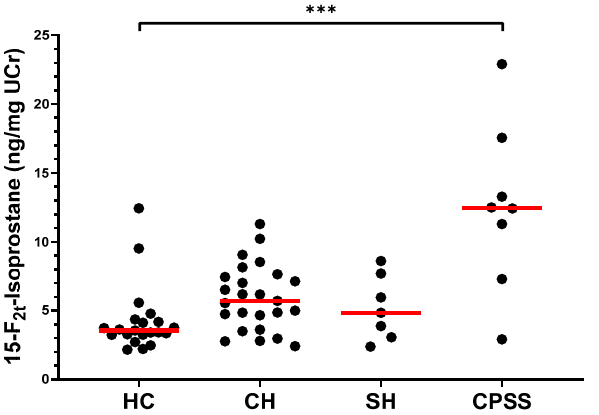
Figure 1. Concentrations of 15-F 2t -isoprostane (ng/mg UCr) in the urine of healthy dogs and dogs with CH, SH, or CPSS. The median of each group is represented by a red line. Asterisks (***) repre- sent a significant difference at P < 0.001. All other comparisons between groups were not signifi- cantly different at P = 0.05. Abbreviations: HC, healthy controls; CH, chronic hepatitis; SH, steroid hepatopathy; CPSS, congenital portosystemic shunt; UCr, urinary creatinine. The tissue copper quantification results for CH dogs greatly varied, ranging from 12 ppm to 3108 ppm (median: 407 ppm, Supplementary Figure S6). No correlation appeared to exist between F 2 -IsoP concentrations and the amount of copper measured in the liver biopsies from CH dogs (Spearman r = − 0.114, P = 0.596, Figure 2).